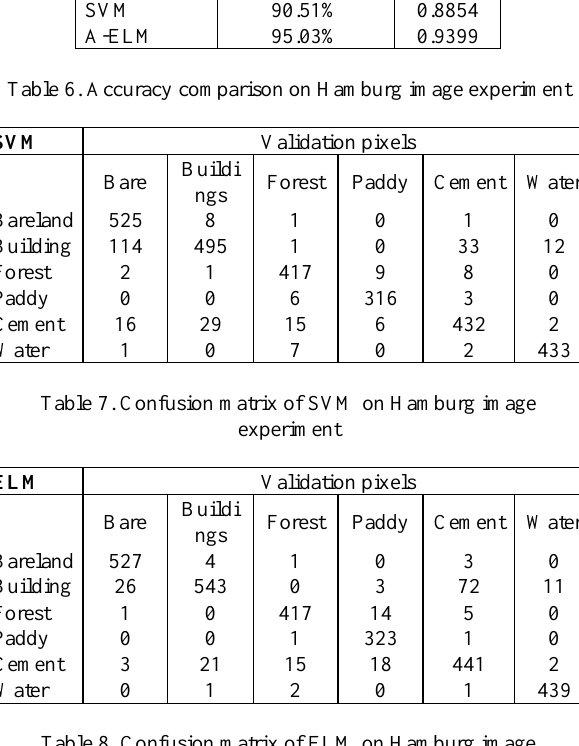
Table 8. Confusion matrix of ELM on Hamburg image